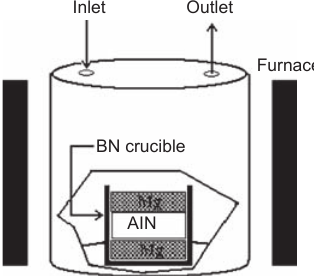
Figure 2 Experimental temperature profi le with 4 ° C/min heat- -t (25, 60, 90, and 135 min), T = 650 ° C, 800 ° C, and ing rate: ∆ t = t 2 1 950 °